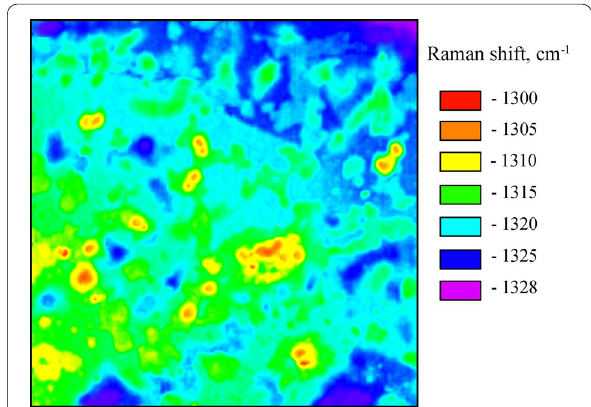
Fig. 7 Image of fine Raman mapping of the 150 area of the narrow BDD plate. Colors indicate the diamond Raman peak position at different surface